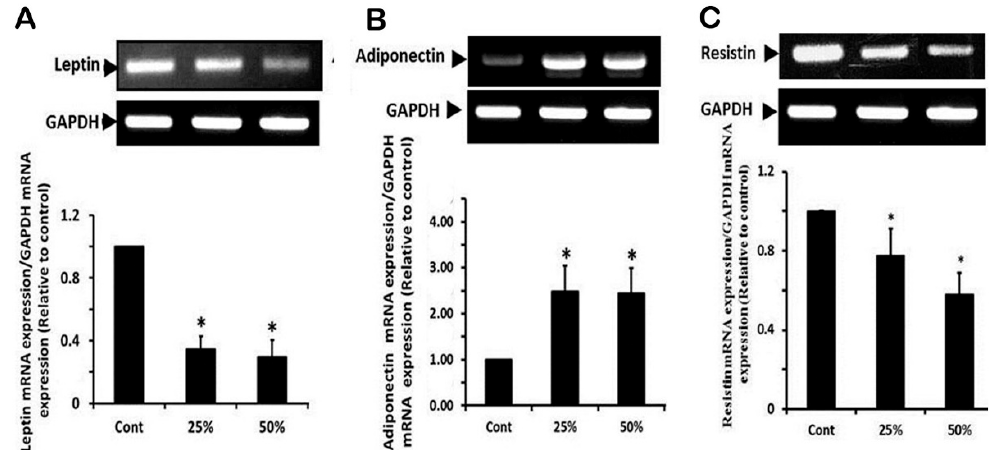
Figure 4. Effect of ginger water on leptin ( A ), adiponectin ( B ), and resistin ( C ), and expression of mRNA in white adipose tissue of rat. Results of densitometric analyses and demonstrative blots of at least five independent experiments are displayed. Values are expressed as means ± SE. Cont: control, 25%:25% ( v / v ) ginger water-treated group, 50%:50% ( v / v ) ginger water-treated group. * p < 0.05 vs. the control.